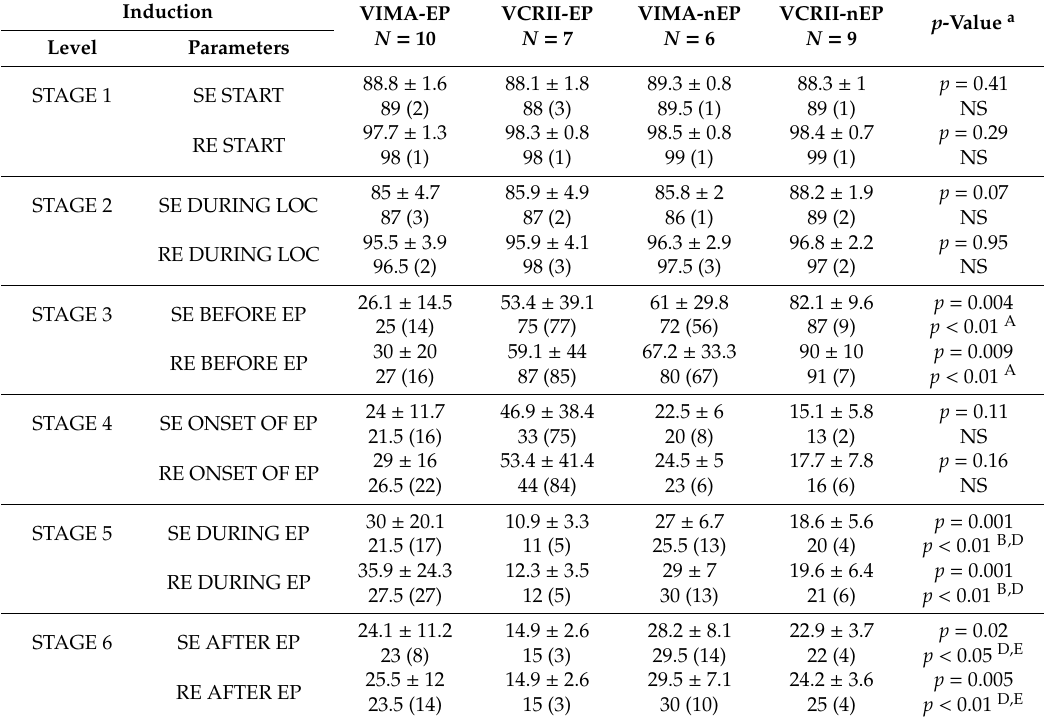
Table 1. Comparison of values of monitored patients’ parameters at the same stage between studied groups (stage 1—before onset of VIGA, stage 2—after LOC, stage 3—before presence of first epileptiform pattern, stage 4—during presence of epileptiform patterns, stage 5—during the highest values of RE and RE during presence of epileptiform patterns in patients from group VIMA and VCRII, Stage 6—during the highest values of RE and RE after disappearance of epileptiform patterns in patients from groups VIMA and